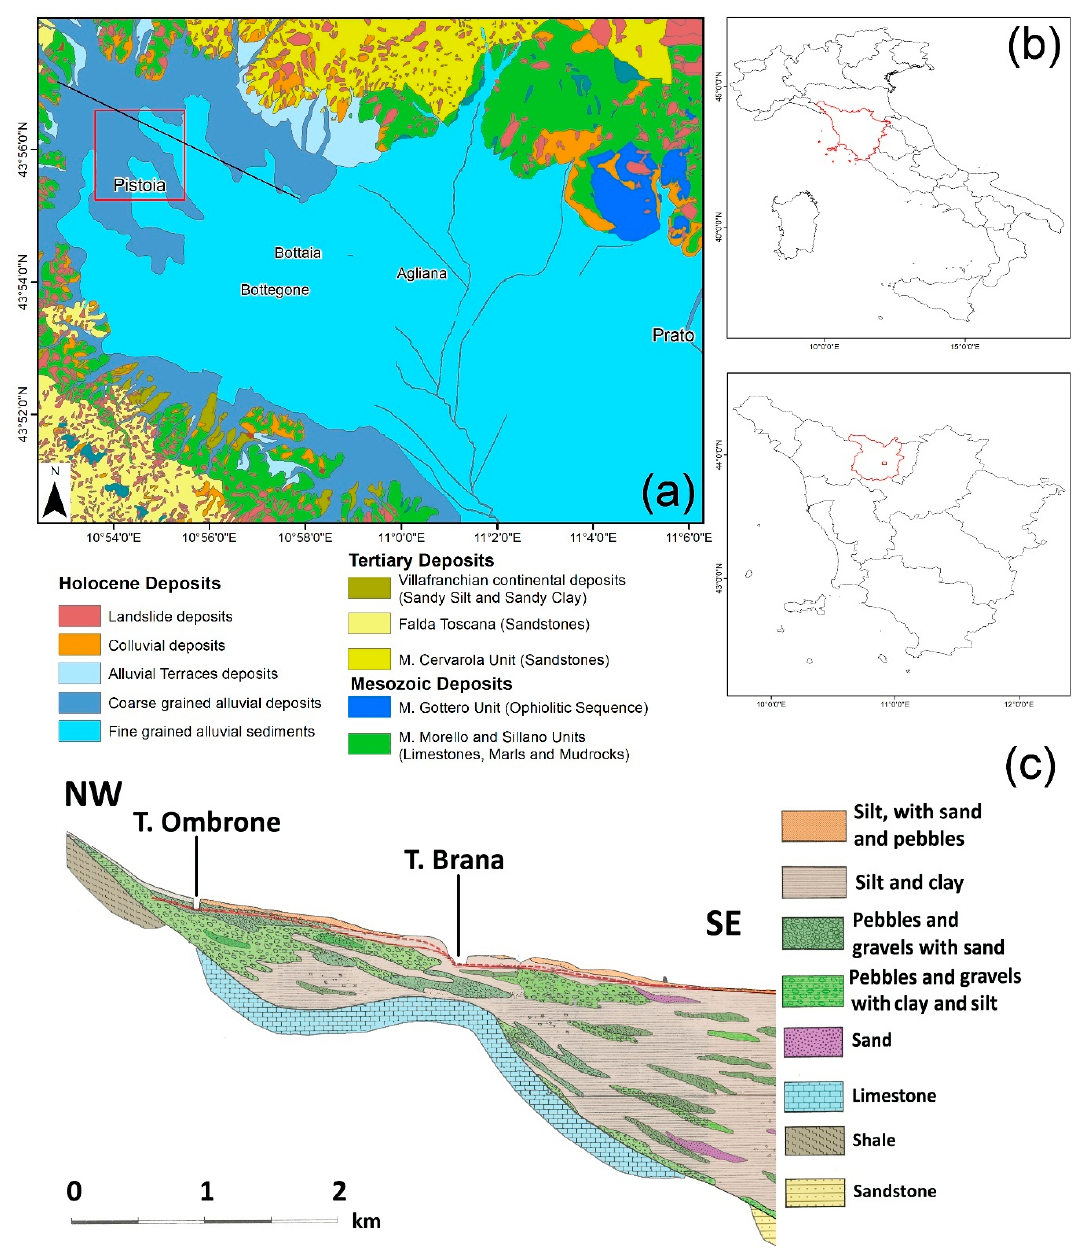
Figure 1. Geographical and geological context of the area of interest. Localization of the city of Pistoia: ( a ) geological map at 1:50,000 scale of the area of interest ( b ) (modified after Puccinelli et al. [38]). The red square shows the area of interest and the black line represents the trace of the geological section reported in ( c ) that has been adapted from Capecchi et al. [35]. The red dashed line represents the natural groundwater level of the basin.